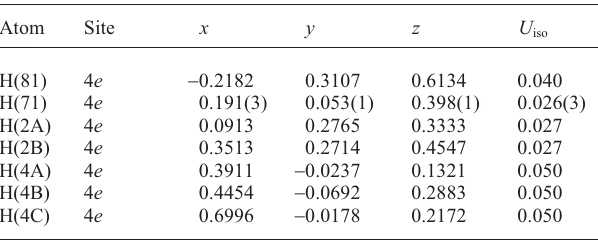
Table 2. Atomic coordinates and displacement parameters (in Å 2 ) .